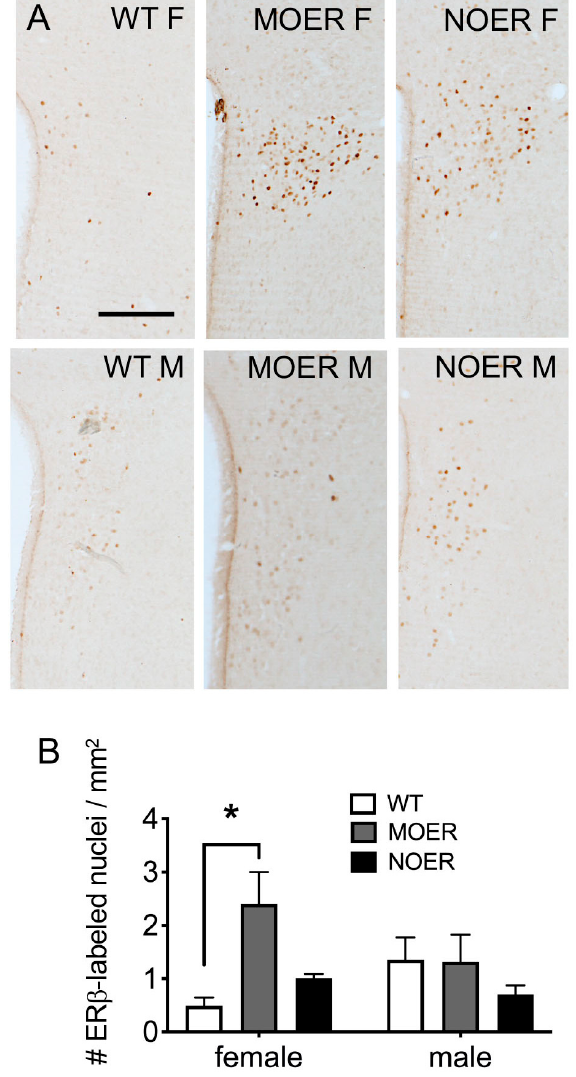
Figure 2. Light microscopic distribution of nuclear ER β in the PVN from WT, MOER, and NOER female and male mice. ( A ) Representative micrographs of nuclear ER β labeling in the PVN from WT, MOER, and NOER mice. ( B ) The density of ER β -labeled nuclei (i.e., number of nuclei/mm 2 ) in the PVN was greater in MOER females compared to WT females ( n = 3 WT, 4 MOER, and 3 NOER females; n = 3 WT, 4 MOER, and 3 NOER males). * p < 0.05; scale bar (A) = 100 microns.